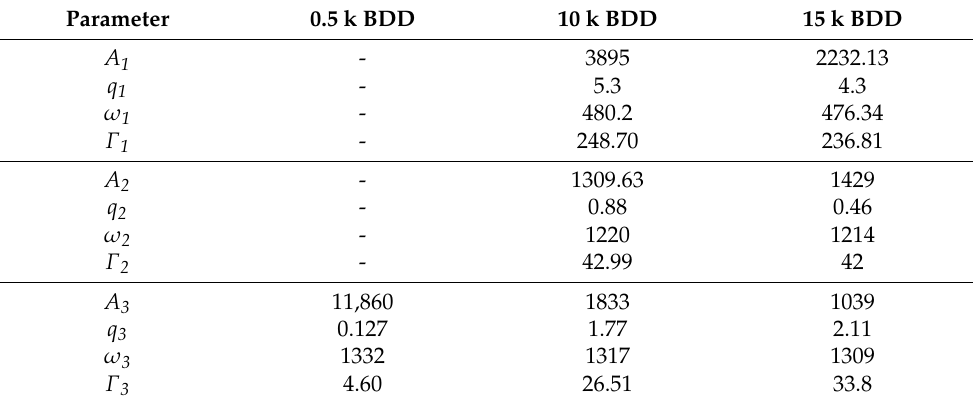
Table 2. Fitting parameters of BDD electrodes. Indices 1, 2, and 3 correspond to the BWF#1, BWF#2, and BWF#3 bands, respectively.